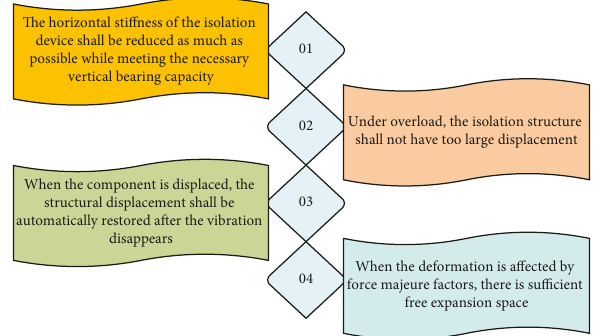
Figure 1: Structural diagram of “wood weaving.”